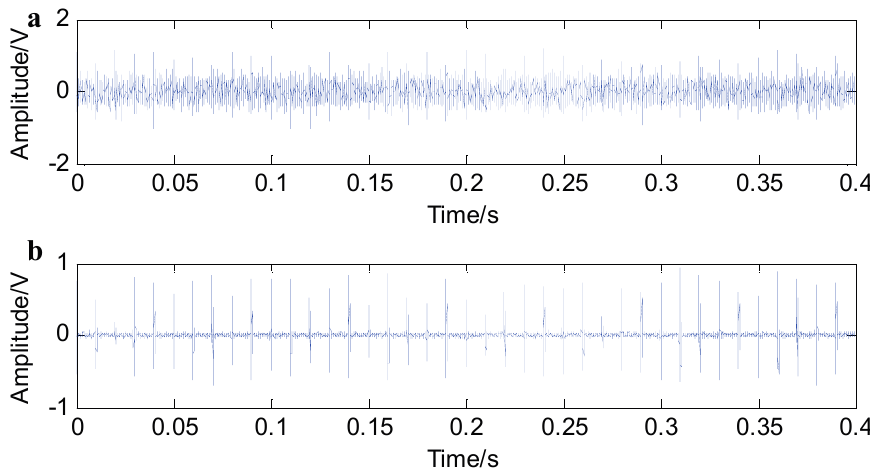
Figure 4. Simulated fault signal of rolling bearing with SNR = 2 dB ( a ); and filtered signal with fast NL-Means ( b ).